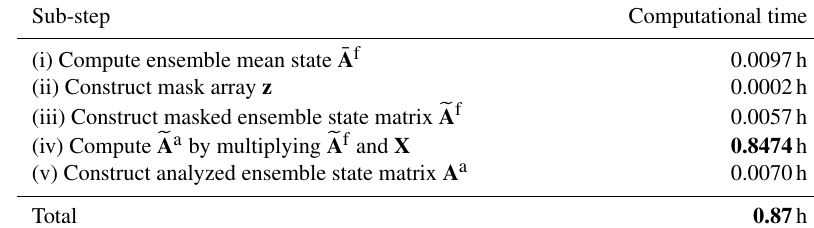
Table 2. Computational evaluation of all the steps of the mask-state algorithm (MS) for A a = A f X . (See the details of each step of MS in Sect.